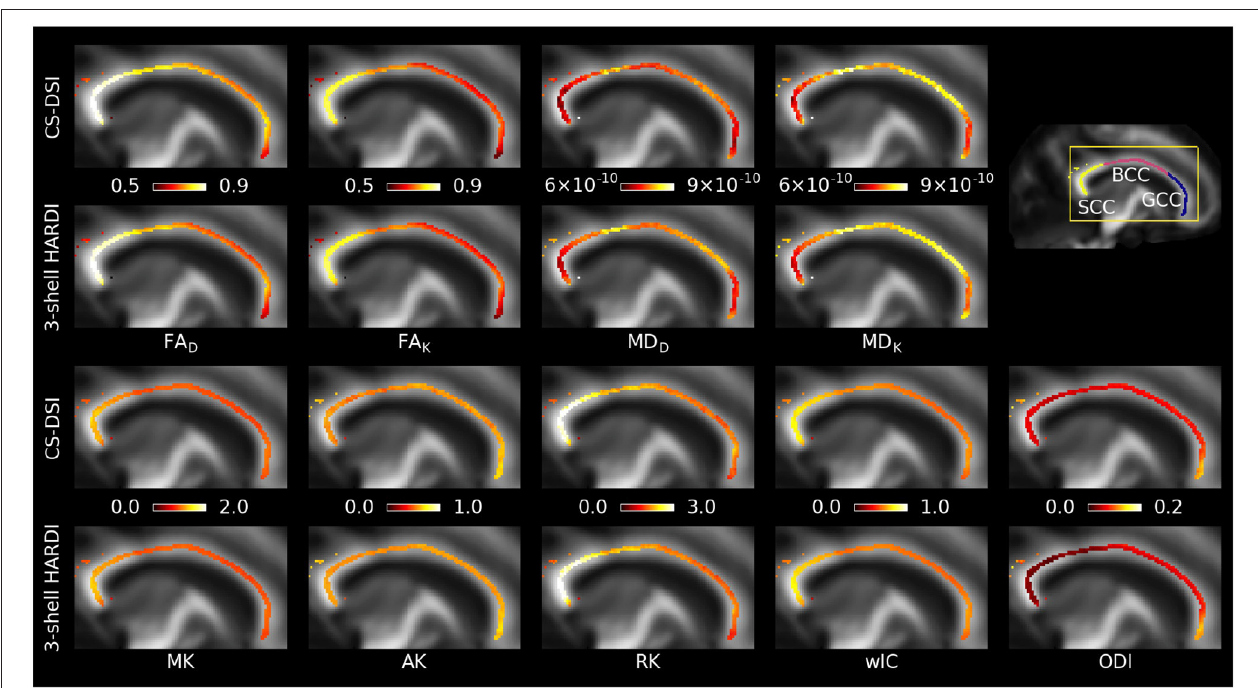
FIGURE 6 | Sagittal view of group mean values across CC voxels on the TBSS white matter skeleton for parameters estimated from the tensor (FA D , MD D ), kurtosis (FA K , MD K , MK, AK, RK), and NODDI (wIC, ODI) model overlaid on the FA map in WM atlas space. (Top two rows) Kurtosis model fitting reduces the differences in FA and MD between CS-DSI and 3-shell HARDI compared to the tensor model. (Bottom two rows) Comparable kurtosis and NODDI metrics are derived for both acquisition schemes. Diffusivities are given in units of m 2